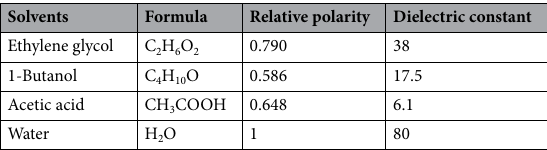
Table 1. Fundamental physicochemical properties of used